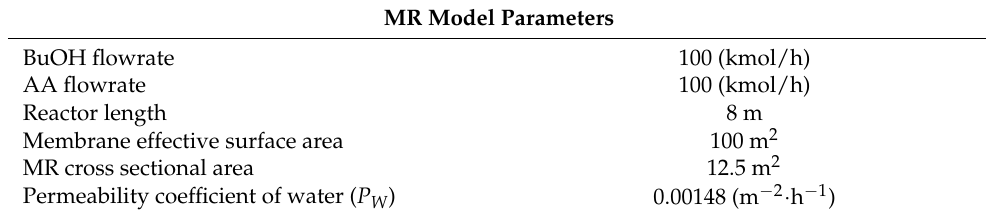
Table 1. Membrane reactor model